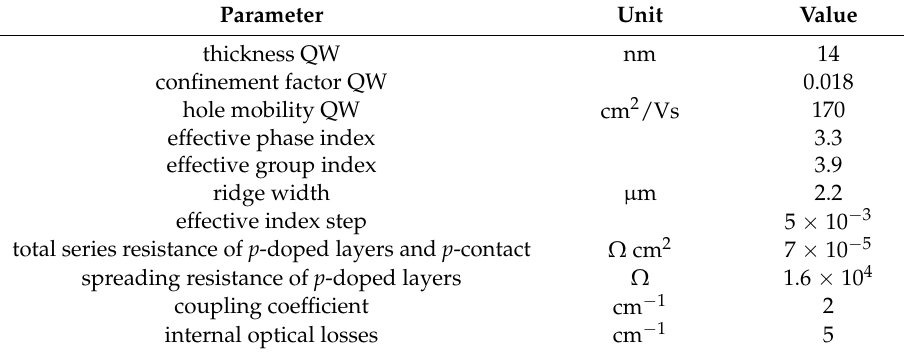
Table 1. Summary of important parameters used in the simulation. QW: quantum well.